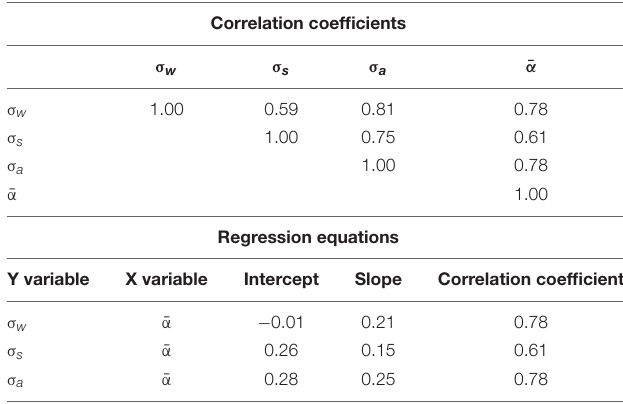
TABLE 3 | Correlation coefficients and regression equations for standard deviations of winter, summer, and annual balances and means of balance